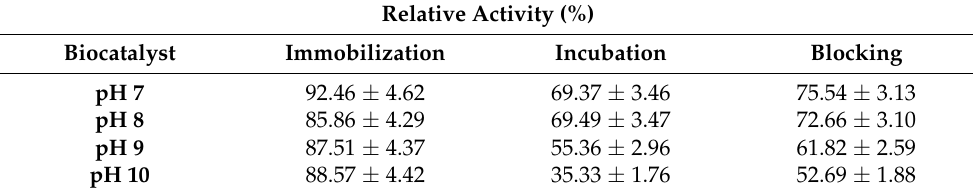
Table 2. Effect of the incubation pH on the expressed activity of PGA immobilized on VS-agarose. The enzyme was immobilized at pH 7.0 (see legend of Table 1). Incubation was performed in 50 mM of each buffer (containing 100 mM phenyl acetic acid and 30% glycerol); sodium phosphate at pH 7.0, sodium phosphate at pH 8.0, sodium carbonate at pH 9.0 and sodium carbonate at pH 10.0 for 3 h.